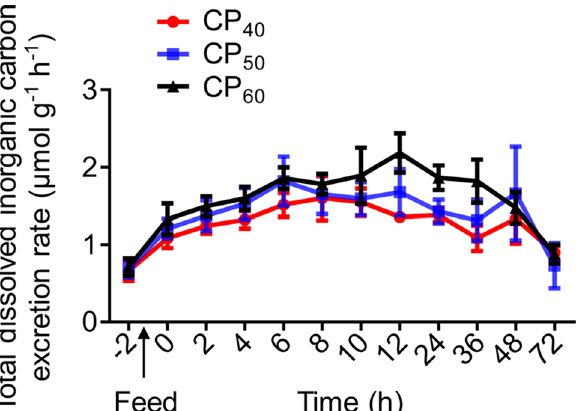
Figure 5. Total dissolved inorganic carbon excretion rate ( M DIC, μmol g −1 h −1 ) in juvenile Sagmariasus verreauxi . Lobsters were reared at 21 °C and fed 15 N-labeled feeds at 1.5% body weight at three crude protein levels: 40%, 50% and 60%, corresponding to CP 40 , CP 50 and CP 60 treatments, respectively. The M DIC at − 2 h indicates the routine M DIC. The first post-prandial M DIC was recorded at 0 h. All data represent mean ± standard error (SE) of 5 to 6